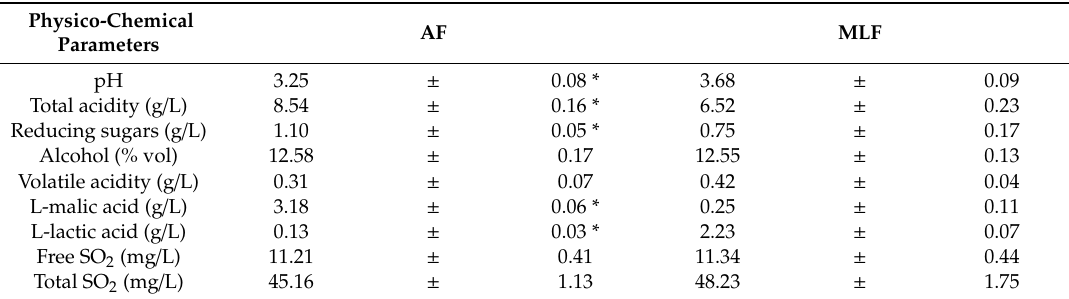
Table 1. Physico-chemical analysis of wine at the end of alcoholic fermentation (AF) and at the end of malolactic fermentation (MLF). The wine was obtained with the sequential inoculation pre-adapted (Batch